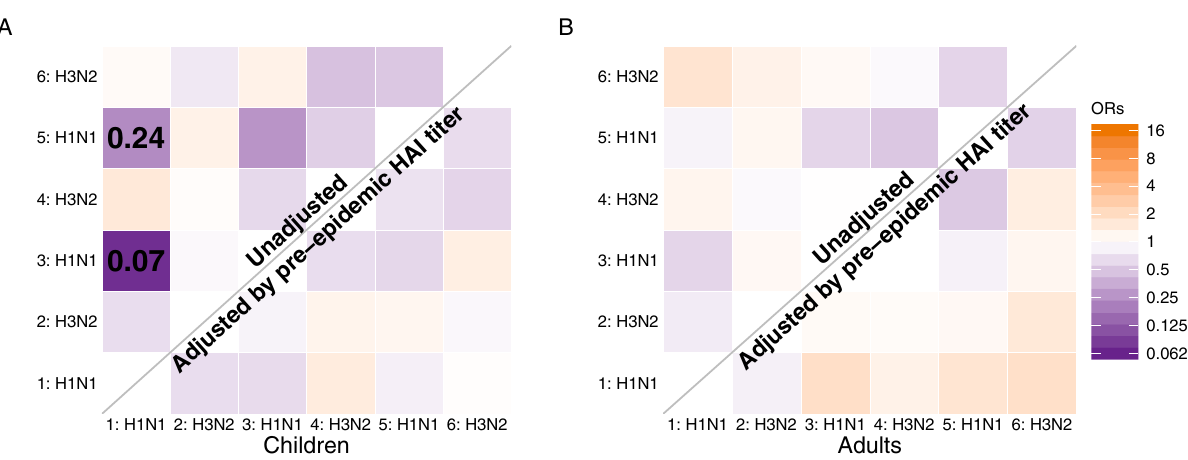
Fig. 3 The association between infection status in different epidemics. The association between the infection status in each pair of epidemics in the study period. Upper and lower diagonal shows the odds ratio without adjustment and adjusting pre-epidemic HAI titer respectively. A , B Indicate the association for children and adults